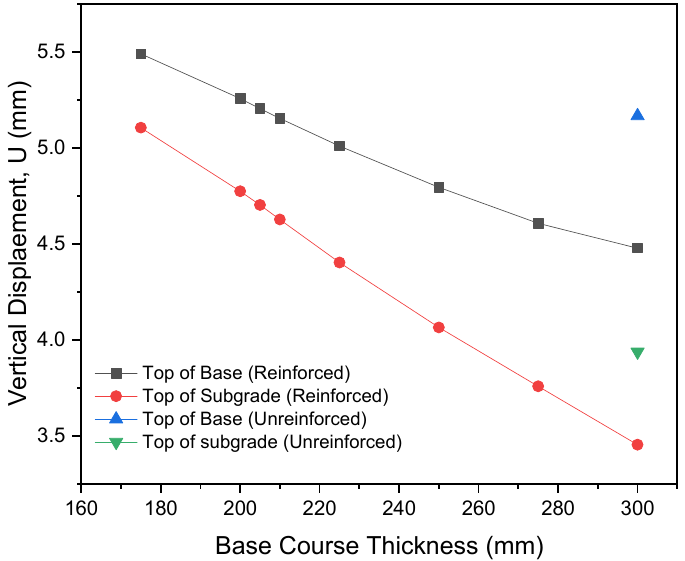
Figure 9. Magnitude of vertical displacement on top of the base and subgrade for different base course thicknesses.